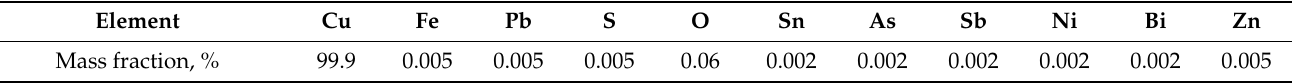
Table 2. Chemical composition of T2 copper (mass fraction, %).